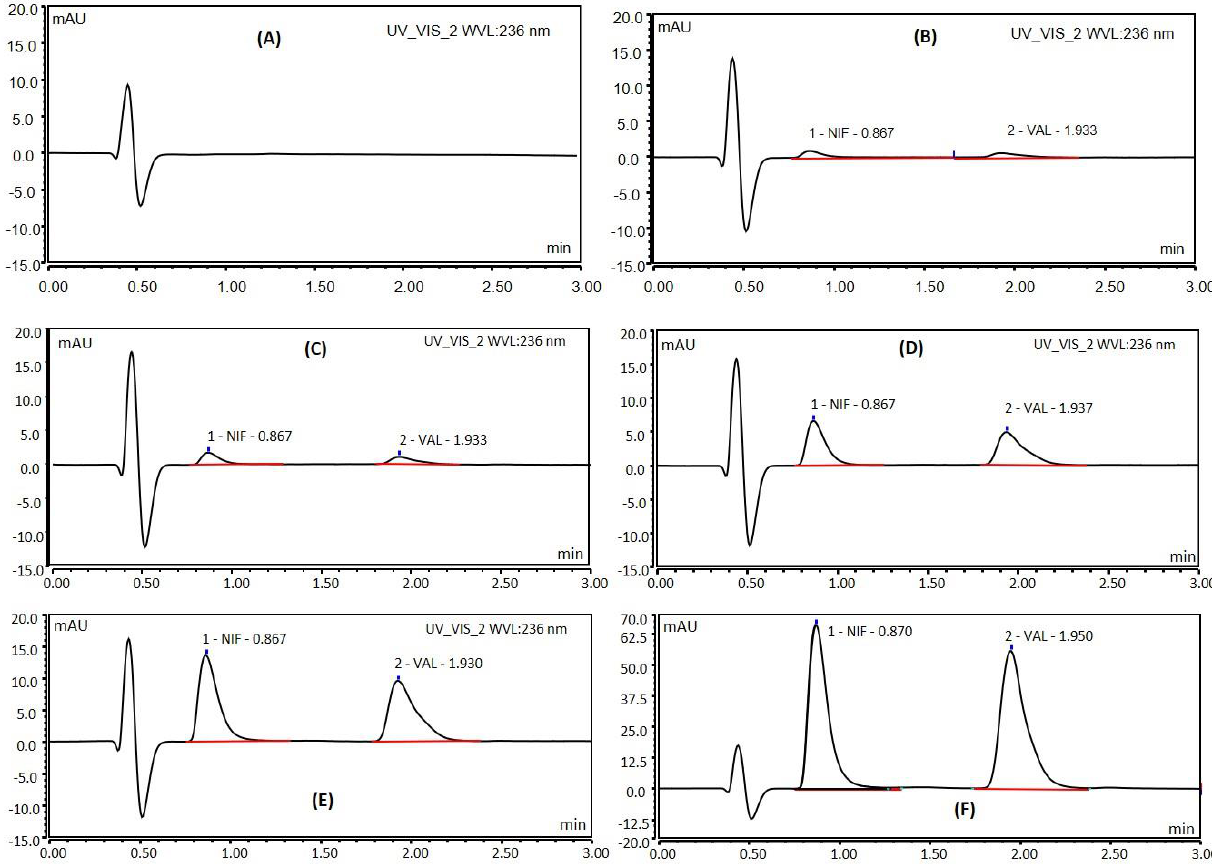
Figure 2. UHPLC spectra of Nifedipine (NIF) and Valsartan (VAL) at various concentrations. ( A ) a blank (drug free) chromatogram. ( B ) NIF and VAL retention time at 1 ppm. ( C ) NIF and VAL retention time at 5 ppm. ( D ) NIF and VAL retention time at 10 ppm. ( E ) NIF and VAL retention time at 25 ppm. ( F ) NIF and VAL retention time at 50 ppm. The intensity of absorbance was expressed in milli-absorbance unit (mAU) and time in minutes. The peak asymmetry of the sample run is presented in Table